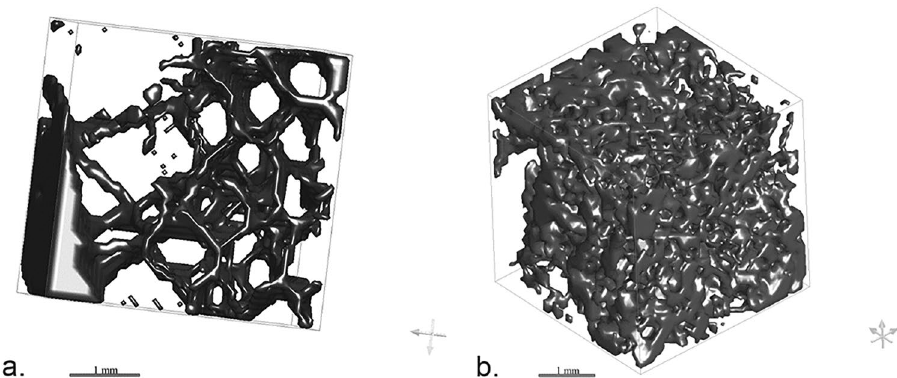
Figure 5. Contour meshes (cubic boxes with size 4 mm) of the trabecular microarchitecture of the bone far from the callus (healthy bone— a ) and of a callus with a PTST of 86 days ( b ). Dragonfly software, Version 2020.1.1.809 (academic licence) from Object Research Systems (ORS) Inc, Montreal, Canada, 2020 (software available at http:// www. theob jects. com/ drago nfly) was used to generate the volume